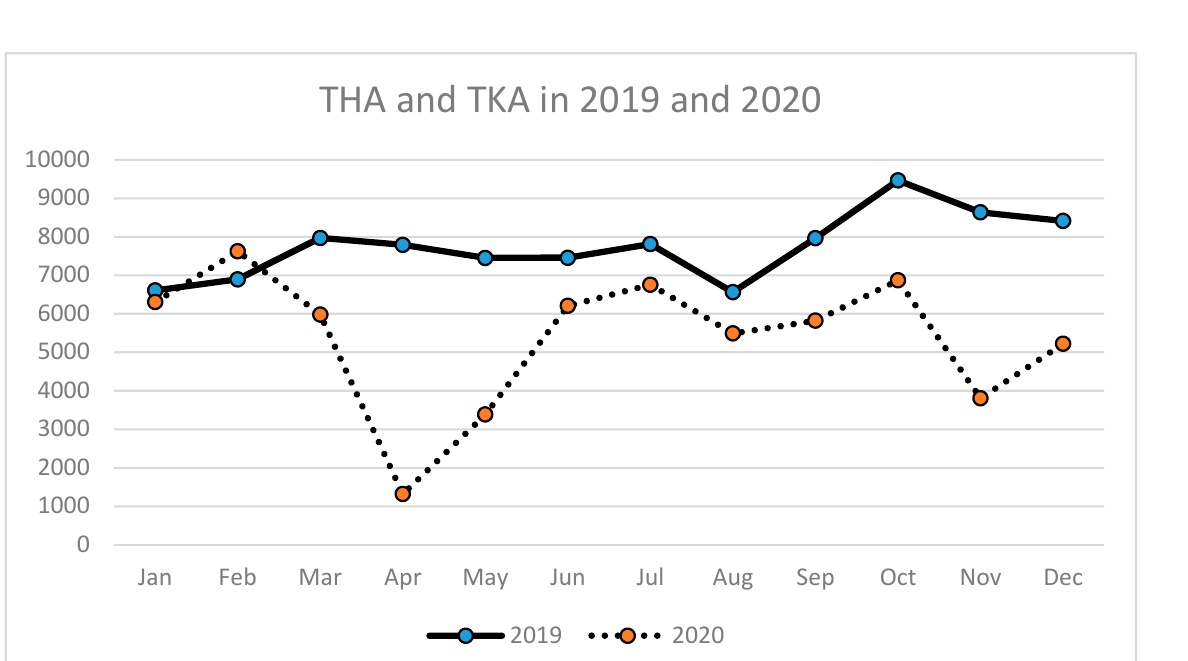
Figure 1. Number of total hip arthroplasties (THA) and total knee arthroplasties (TKA) performed in the particular months of 2019 and 2020 in Poland.